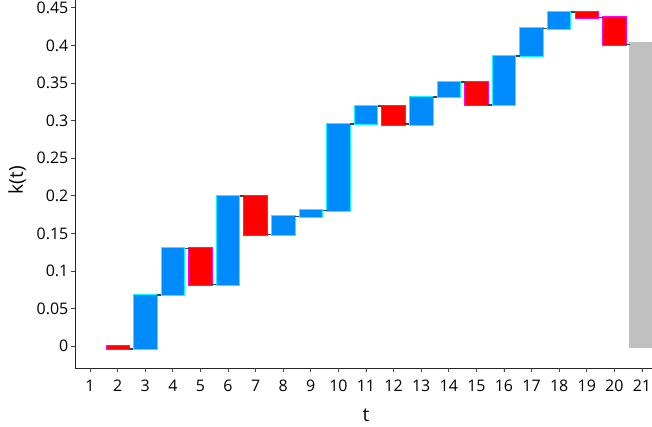
Figure 7. Trade-off between timeliness and